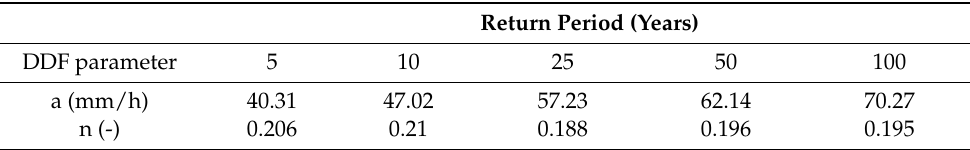
Table 2. DDF parameters of the study area for different return